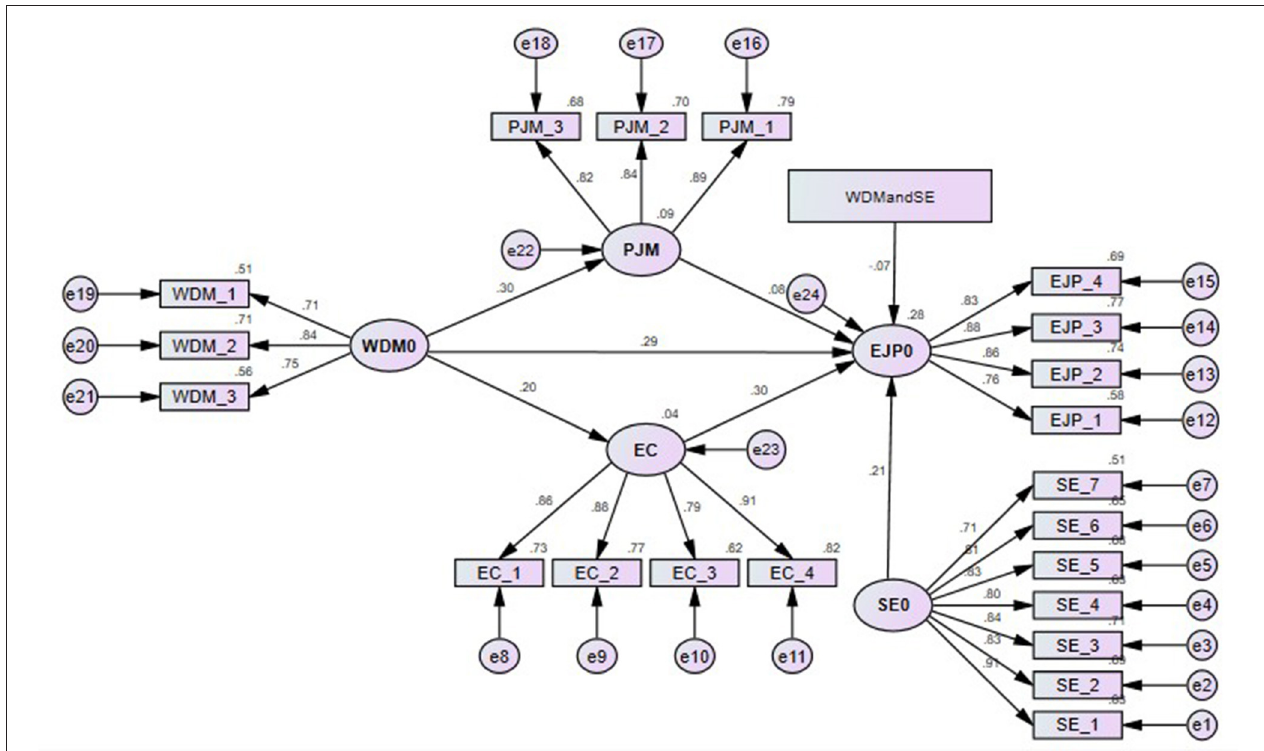
FIGURE 3 | Structural model. WDM, workforce diversity management; PJM, person job match; EC, employee commitment; SE, structural empowerment; EJP, employee job performance.